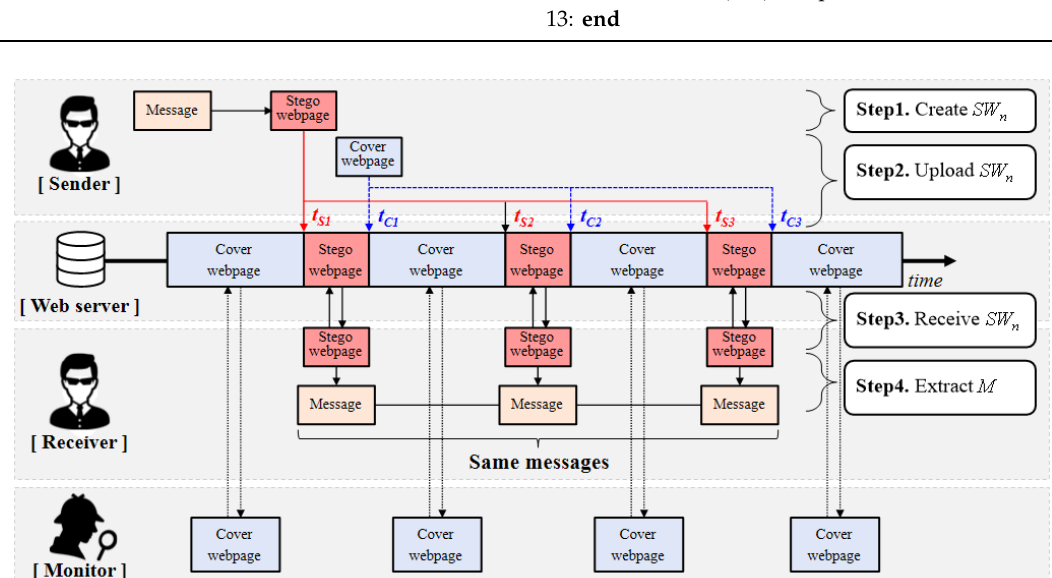
Webpage 𝐶𝑊 : cover webpage